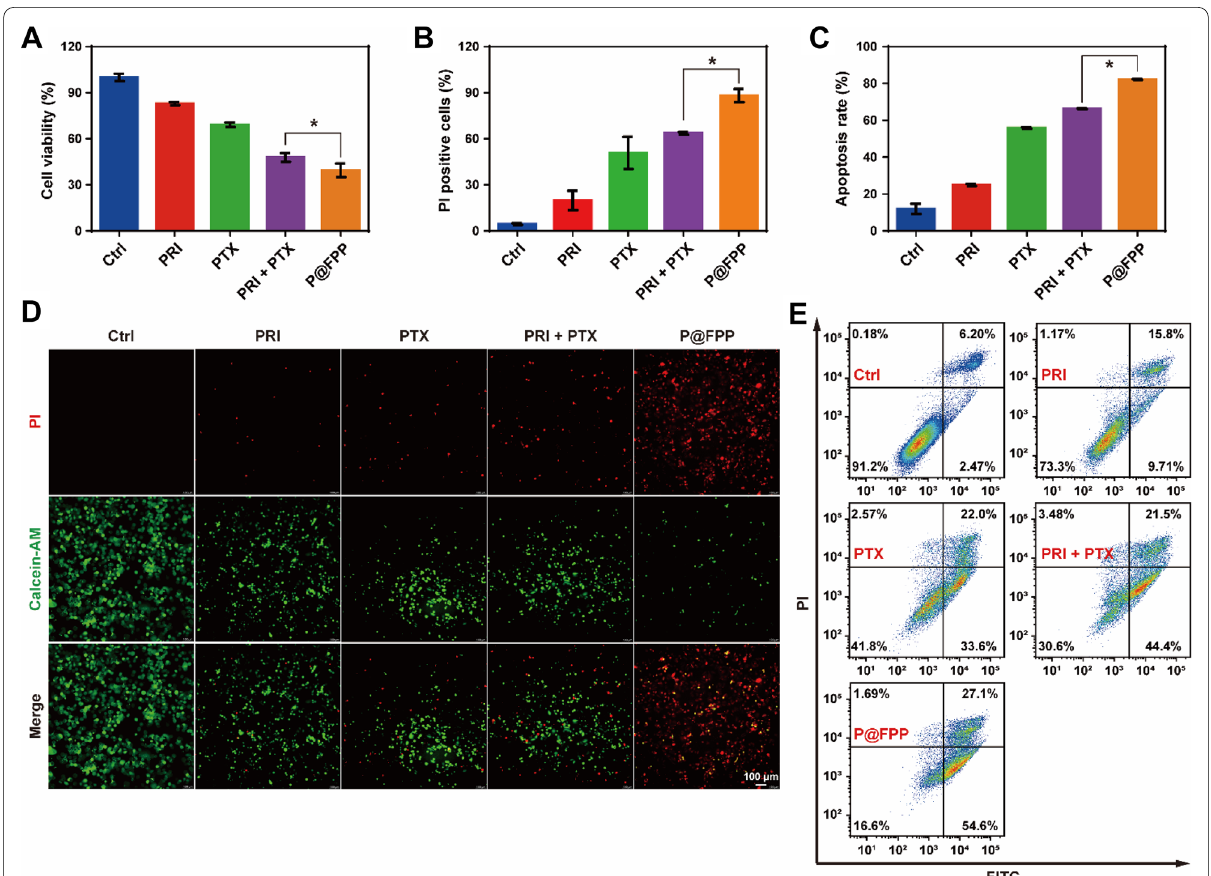
Fig. 5 In vitro cell viability inhibition of P@FPP NMs. A The cell viability of A549 cells detected by CCK8 assay after treatment of PBS, PRI, PTX, PRI PTX, and P@FPP (n 3). B The cell death analysis of A549 cells administrated with different treatments using Calcein-AM/PI staining assays + = (n 3). C Flow cytometry analysis for cell apoptosis of A549 cells treated with different formulations (n = of tumor cells by treatment of different treatments. Green, Calcein-AM; Red, PI. Scale bar: 100 μm. E Representative images for flow cytometry of A549 cells with different treatments. *: P <